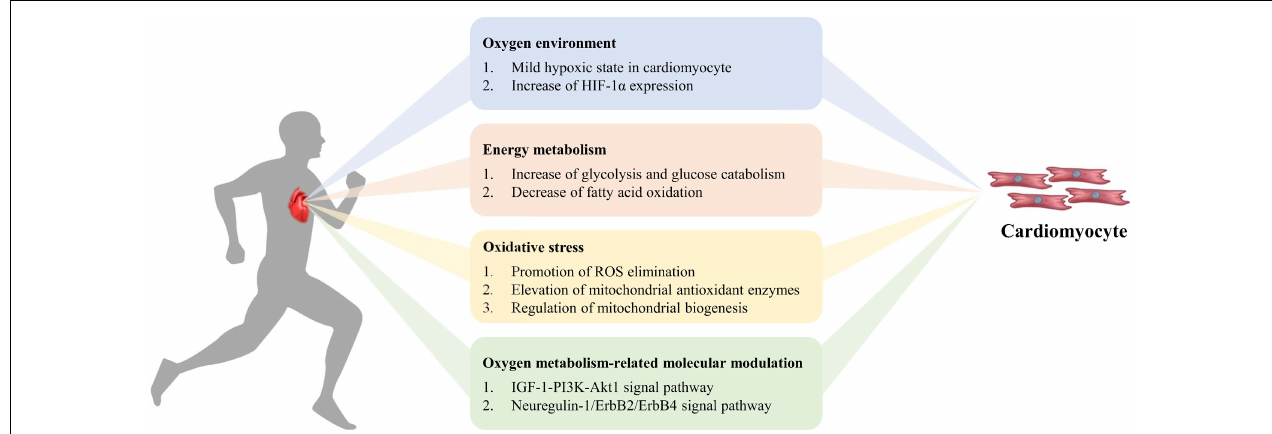
FIGURE 2 | Exercise-induced oxygen metabolism alteration in cardiomyocyte regeneration. During exercise, mild hypoxia and increase of HIF-1 α expression appear in cardiomyocytes. The increase of glycolysis and decrease of fatty acid oxidation influence energy metabolism, to promote ROS elimination, elevate mitochondrial antioxidant enzymes activity, enhance mitochondrial biogenesis, and to improve myocardial antioxidant capacity. Simultaneously oxygen metabolism-related molecular modulation activates cardiomyocyte proliferation via signal pathway.